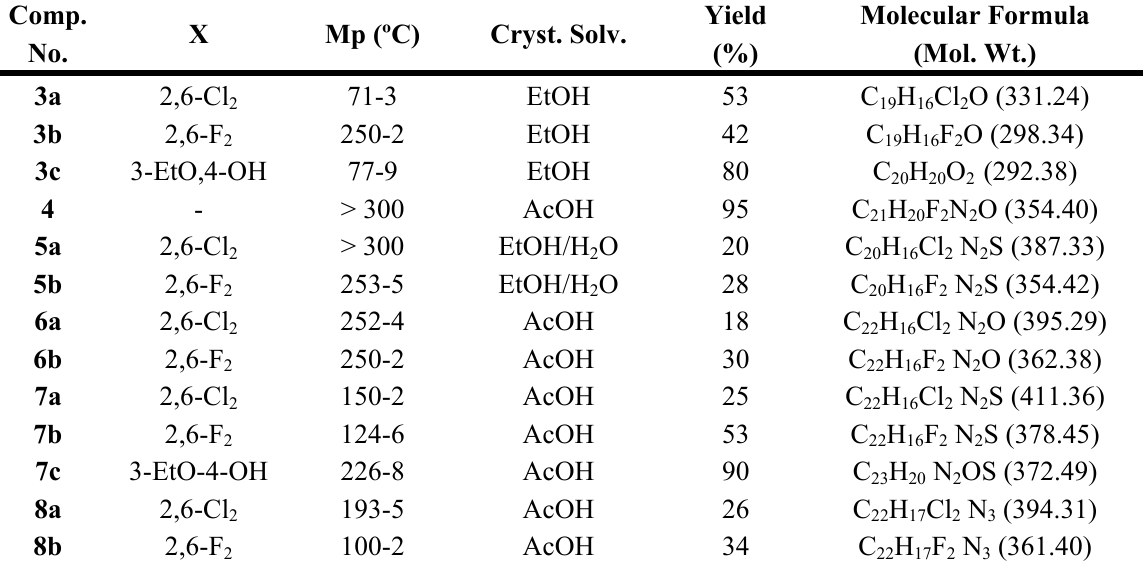
Table 1. Melting points, crystallization solvents, yields, molecular formulae and molecular weights of newly synthesized compounds 3a-c , 4 , 5a , b , 6a , b , 7a-c and 8a , b . Comp.